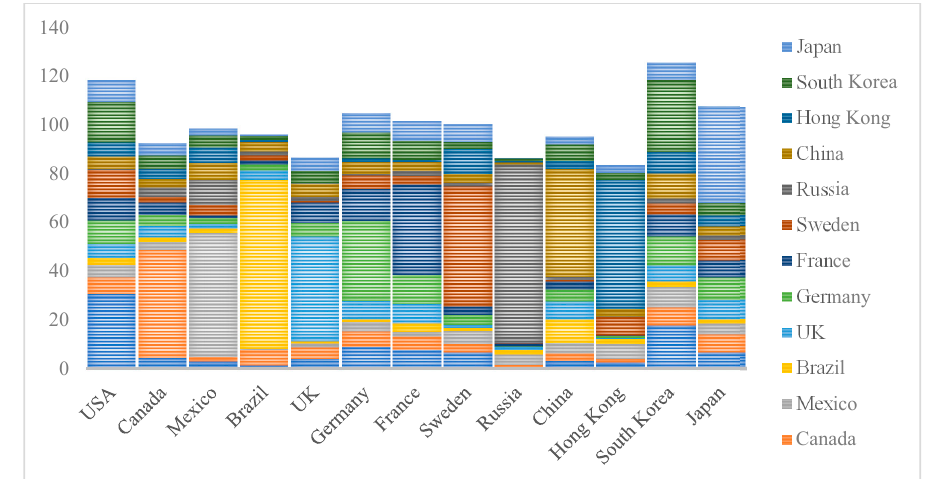
Figure 4. Economic policy uncertainty (EPU) connectedness.